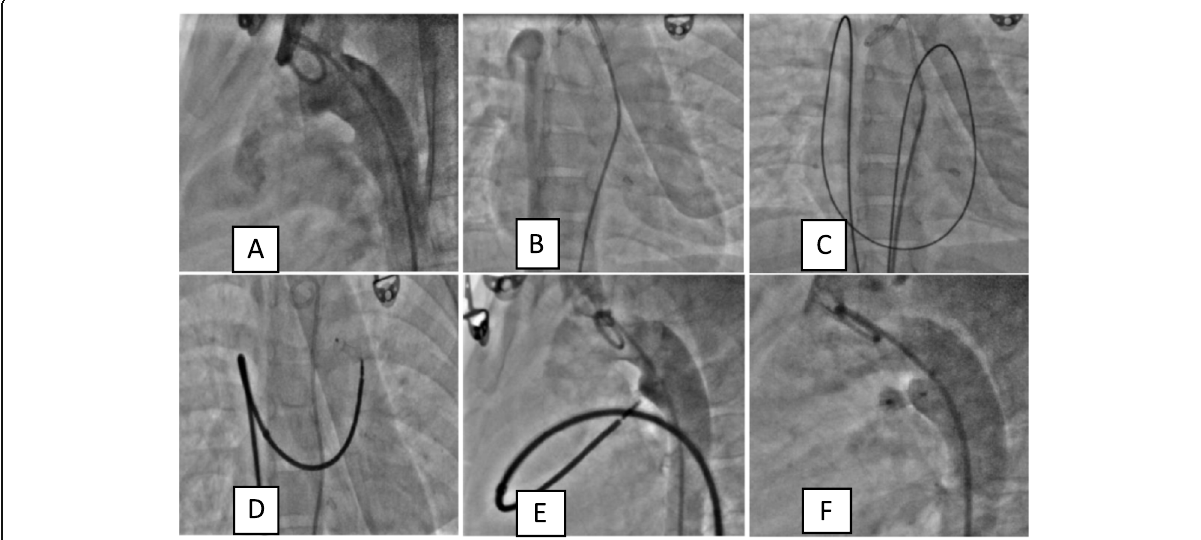
Fig. 1 a Contrast injection through pigtail in the arch of aorta showing type A PDA. b Hand injection of contrast into infrahepatic IVC shows filling of RA via the azygous vein and SVC. c Exchange length Amplatzer extra stiff wire used to cross IVC, azygous vein, SVC, RA, RV, MPA, PDA, and descending thoracic aorta (des TA) in sequence. d ADO I 6 × 4 mm Cocoon device across PDA. e Contrast injection in des TA showing no contrast flow across PDA before release. f Contrast injection in descending TA after device release showing no contrast leak into PA suggestive